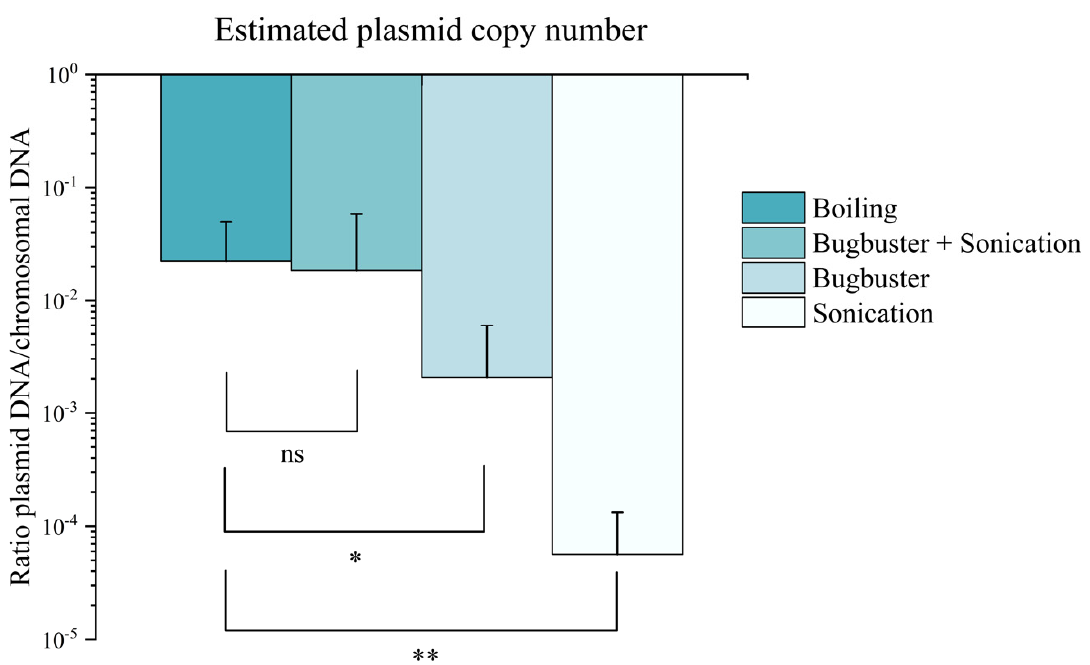
Figure 4. Estimated plasmid copy numbers, as measured by qPCR fluorescence, in gDNA samples obtained by using different lysis methods. Boiling and Bugbuster followed by sonication led to similar results. Error bars represent standard deviation ( n = 12). Statistical significance was calculated with a two-tailed t -test: n.s. = p > 0.05; * = p < 0.05; ** = p < 0.01.